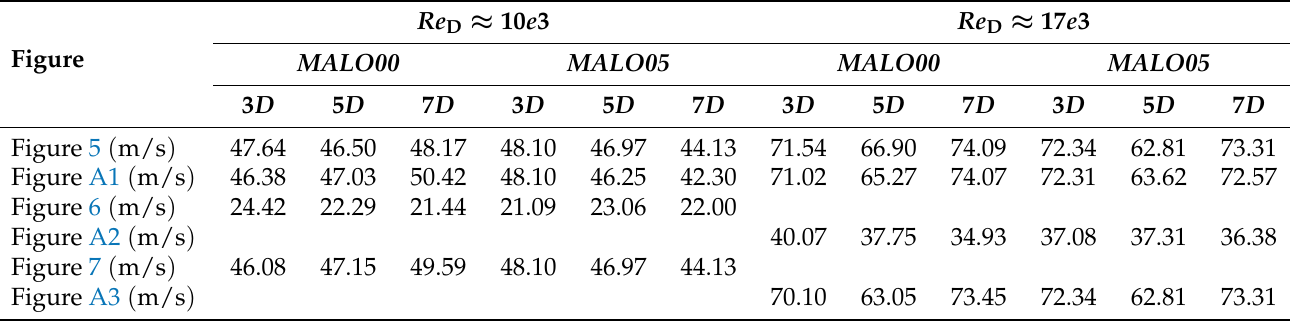
Table A2. Reference values for normalized plot quantities.